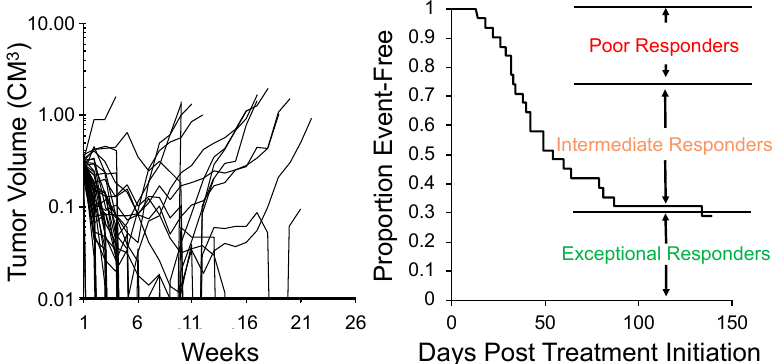
Figure 3. SMT evaluation of trastuzumab-deruxtecan (DS-8201a). Left : Tumor volume response for 35 xenograft models treated with DS-8201a. Each curve represents the growth of an individual tumor. Right : Time to event is replotted as a Kaplan–Meier EFS Probability curve, allowing classification of tumors as poor-, intermediate- or exceptional-responders. Note 5 malignant rhabdoid tumor (MRT) models were maintained CR at week 25.